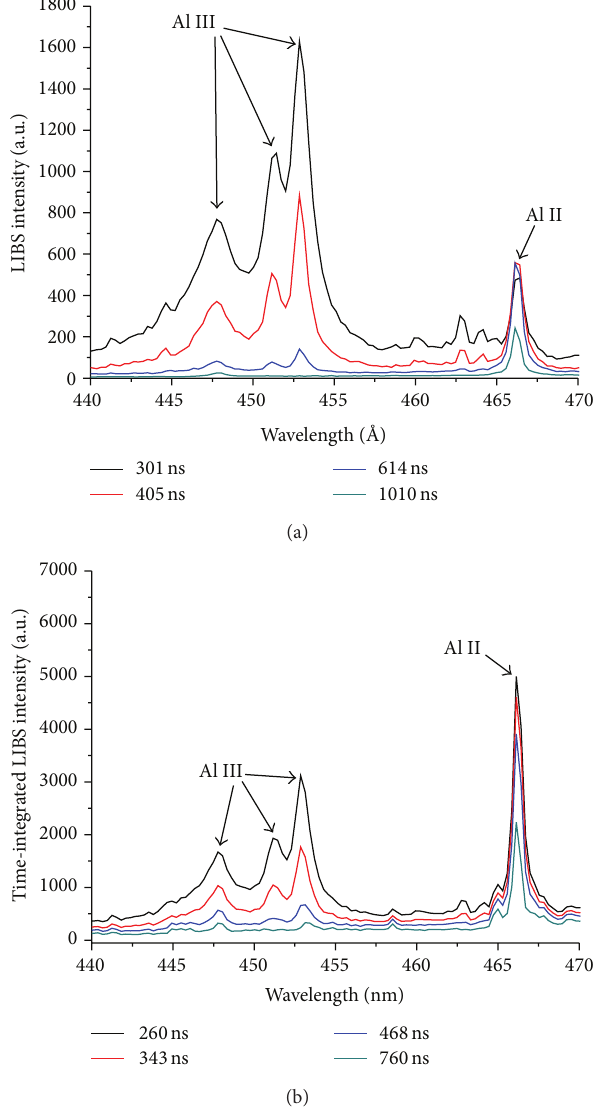
Figure 5: Al III and Al II emission, evaluated from time-resolved (a) and time-integrated (b)